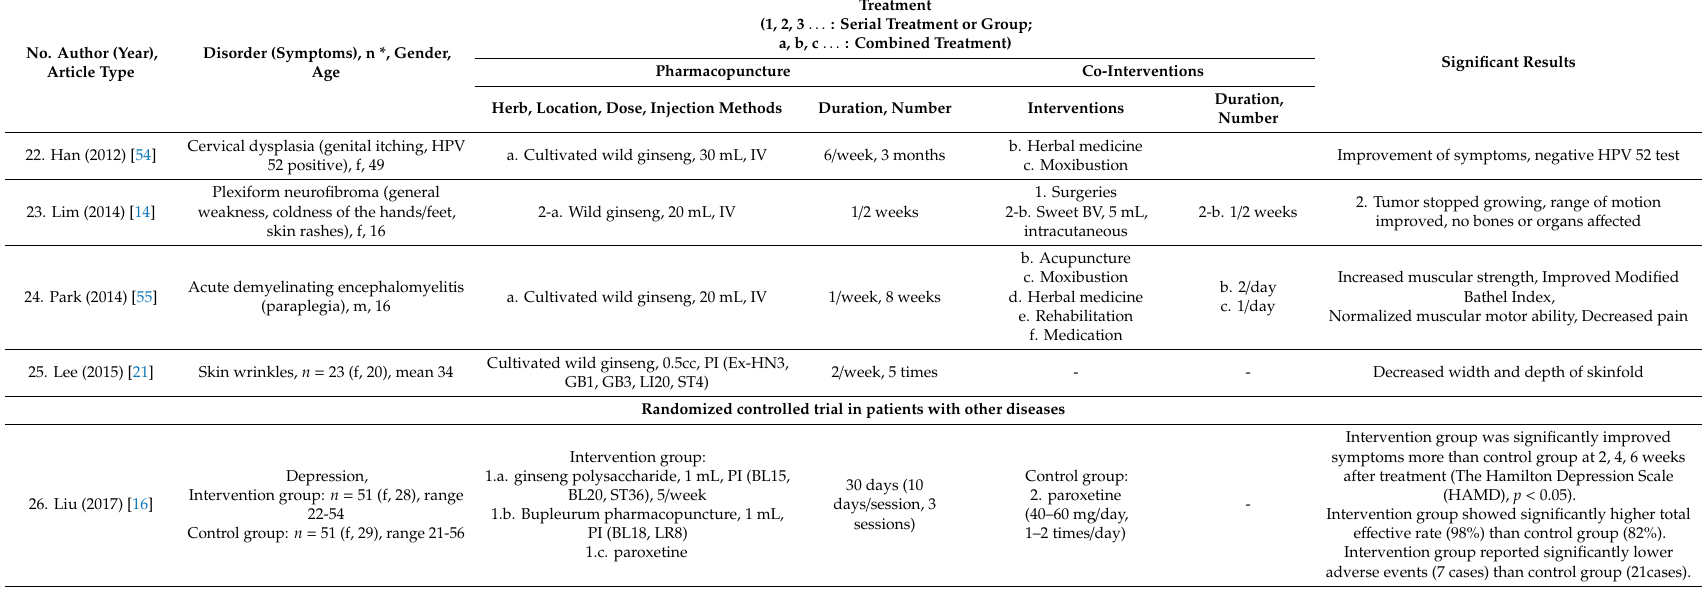
Intervention group was significantly improved symptoms more than control group at 2, 4, 6